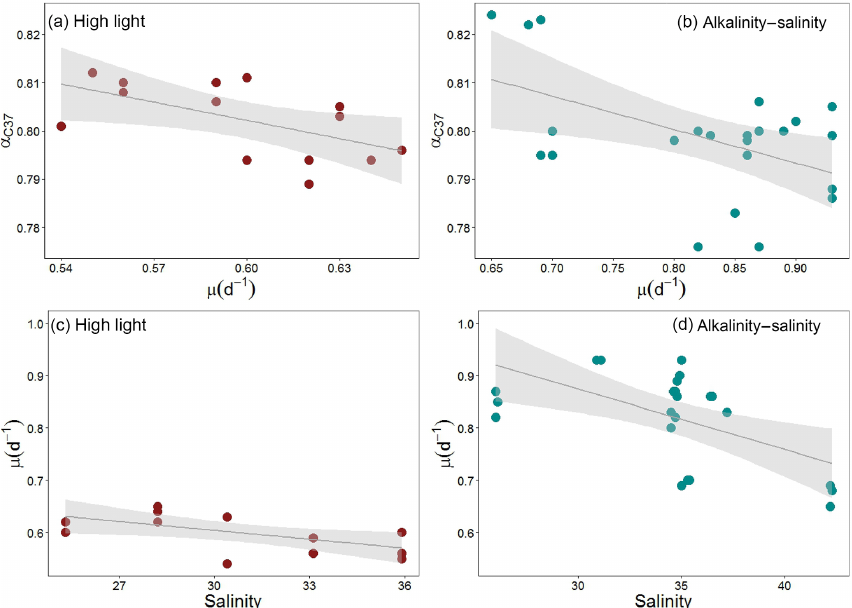
Figure 3. Relationship of growth rate (µd − 1 ) with hydrogen isotope fractionation factor α C the 95% confidence interval for the linear regression model applied to the data. (a) Growth rate and α C experiment shows a weak negative correlation ( R 2 = 0 . 35, n = 14, p < 0 . 05). (b) Growth rate and α C salinity experiment also shows a weak negative correlation ( R 2 = 0 . 25, n = 24, p < 0 . 05). (c) Salinity and growth rate for the high-light experiment ( R 2 = 0 . 29, n = 14, p < 0 . 05). (d) Salinity and growth rate for the alkalinity–salinity experiment ( R 2 = 0 . 29, n = 24, p < 0 .